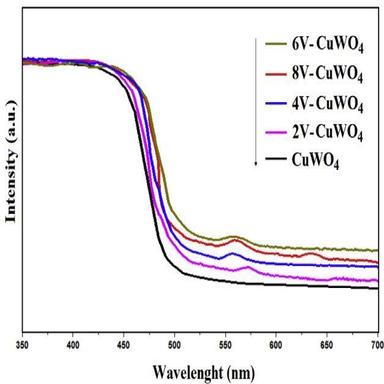
UVeVis absorption spectra of CuWO4 and VeCuWO4.